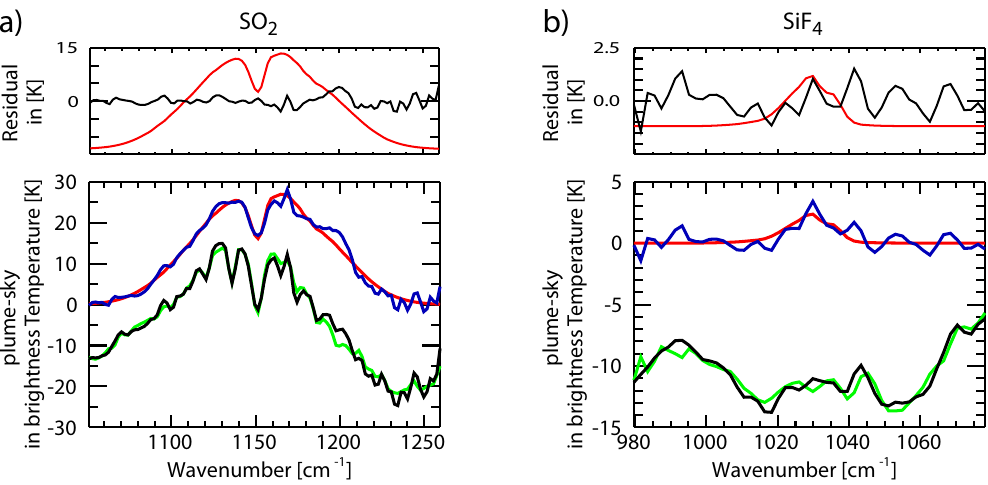
Fig. 3. Spectral regions where SO 2 (a) and SiF 4 (b) are retrieved at 4cm − 1 resolution. Lower plots: The difference of a plume spectrum and a reference-sky spectrum are shown in black and the corresponding fits in green. The same is plotted above for the spectra (blue) and fits (red) when all other fit parameters (continuum radiation and interference gases) are removed. Above: the residuals of the fits for each retrieval window.